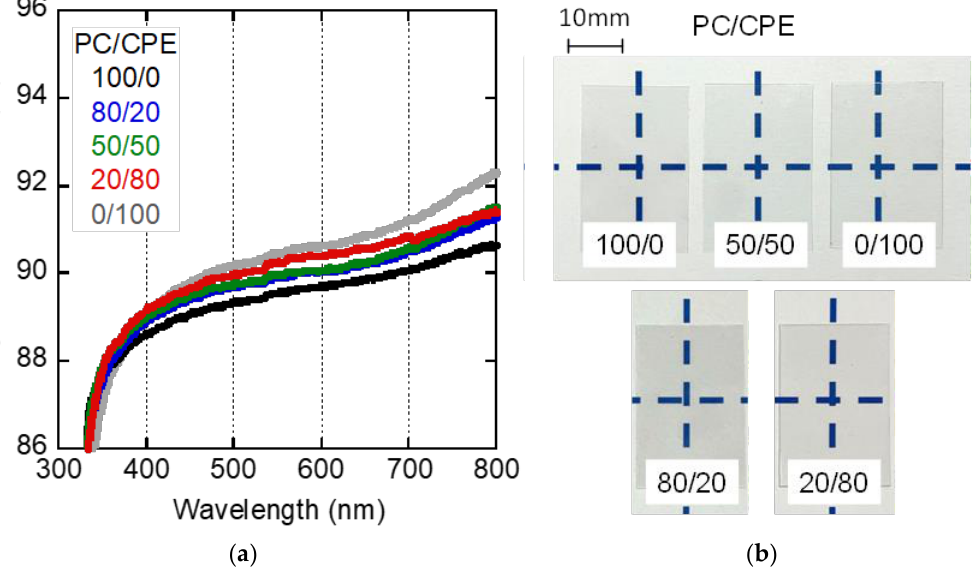
Figure 2. ( a ) Wavelength dispersion of light transmittance of the films with ( b ) optical photographs of PC, CPE, and their blend films.